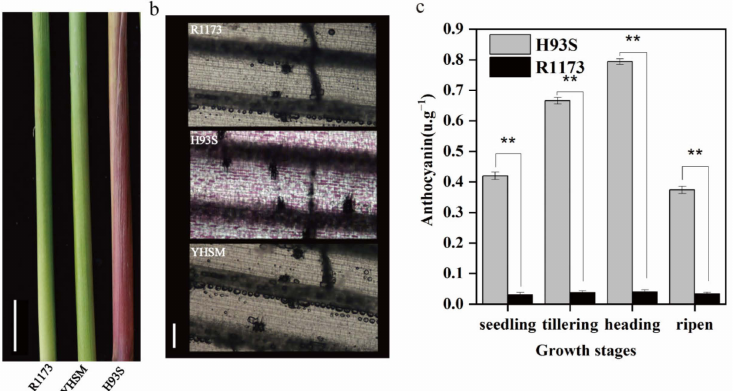
Figure 1. Phenotypes and total anthocyanin contents of purple and green leaf sheath in rice. ( a ), Leaf-sheath phenotypes of parental lines, the scale bar is 7.5 cm. ( b ), The leaf sheath longitudinal sections of parental lines, the scale bar is 100 µ m. ( c ), Total anthocyanin contents in leaf sheath of H93S and R1173 at all growth periods. Values shown are means ± SD, ** indicates a significant difference according to the t -test ( p < 0.01) between H93S and